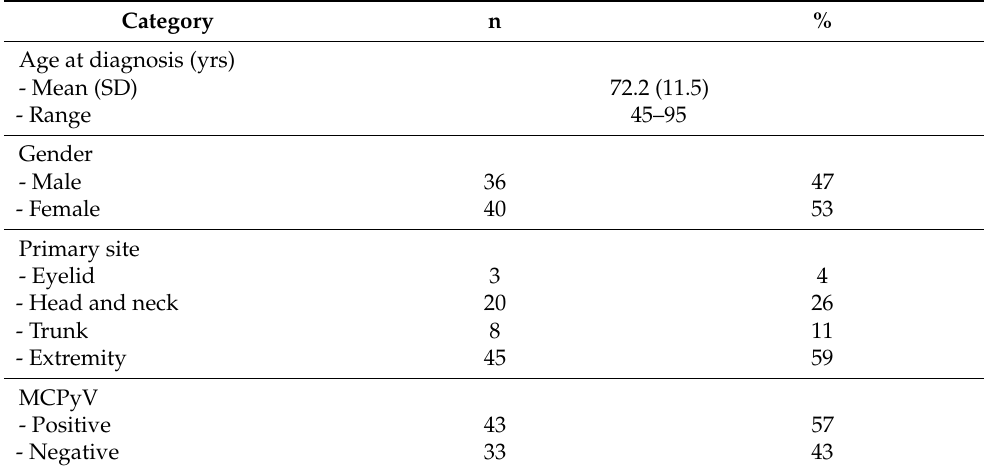
Table 1. Clinicopathological characteristics of patients included in the study (n = 76). Category